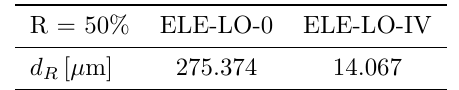
Table 6. Granulometry of the sample and ground